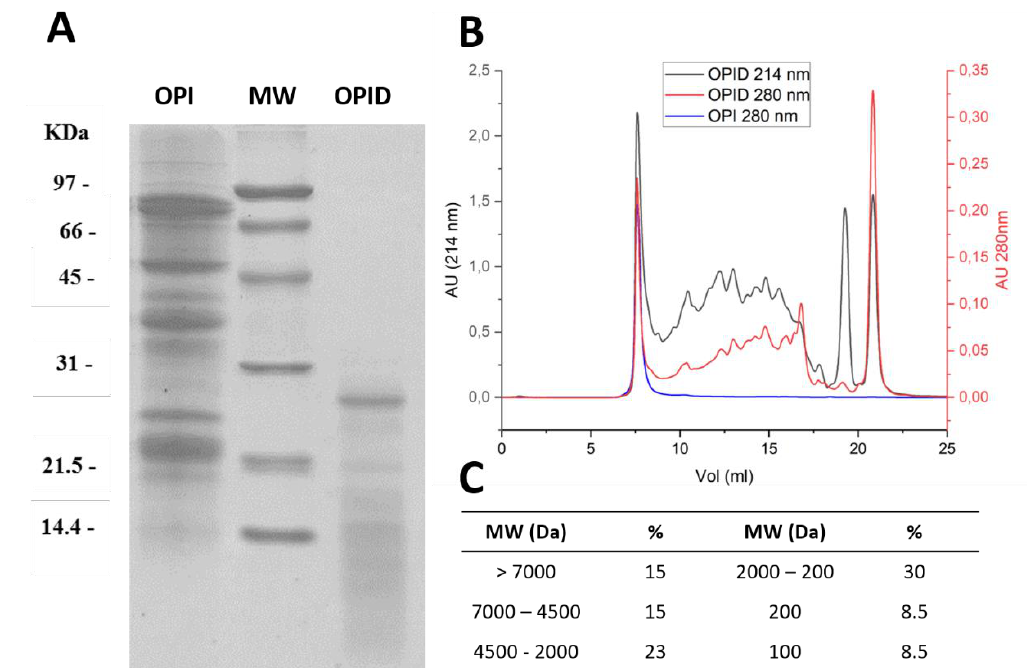
Figure 3. Size distribution of proteins following pancreatin digestion for 24 h. ( A ) 15% SDS-PAGE of Okara Protein Isolate (OPI) and pancreatin digested proteins (OPID). ( B ) Size Exclusion Chromatography (SEC) of OPI (blue) and OPID (red 280 nm; black 214 nm) performed with Superdex 30 increase 10/300 for peptide separation. ( C ) Molecular Weights (MW) distribution calculated according to the calibration with standard MW markers, as detailed in M&M, and expressed as % of the total peaks area.